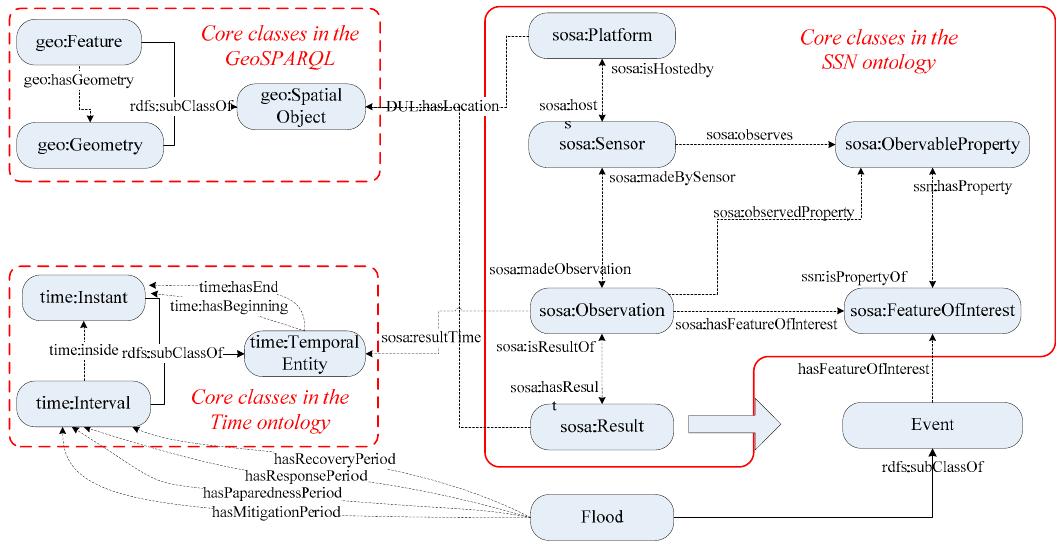
Figure 1. The core classes and properties in the hydrological/flood ontology based on Semantic Sensor Network (SSN).